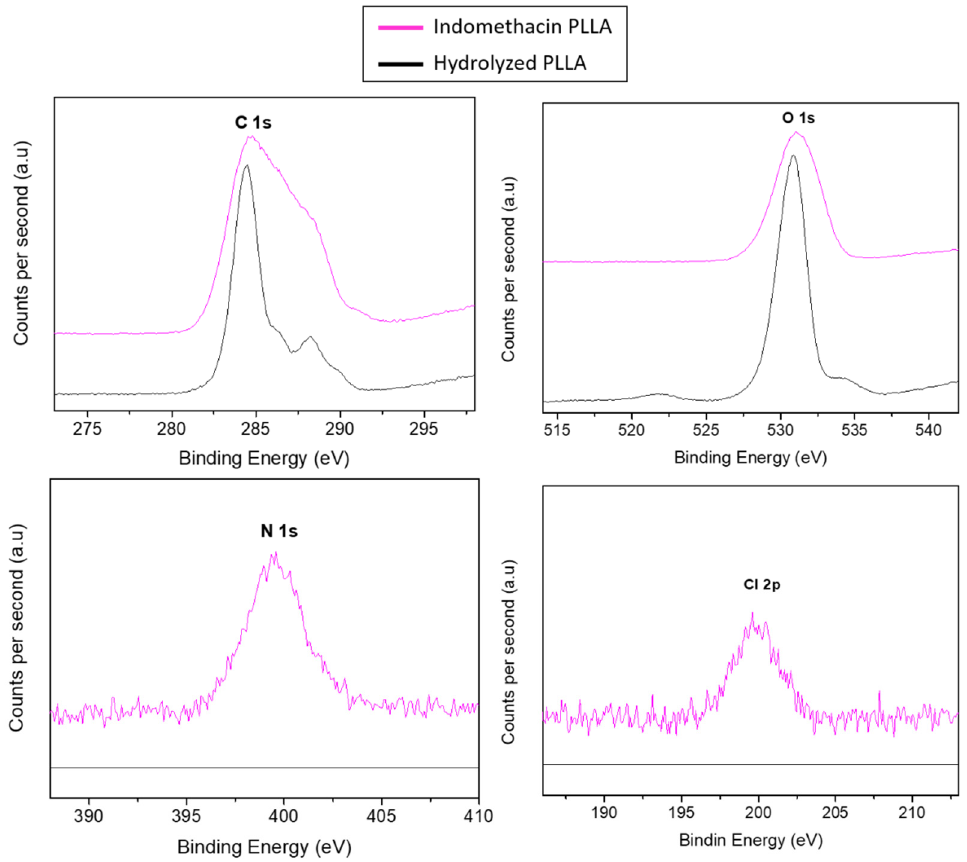
Figure 4. XPS spectra of indomethacin derivative 3a immobilized on PLLA film.